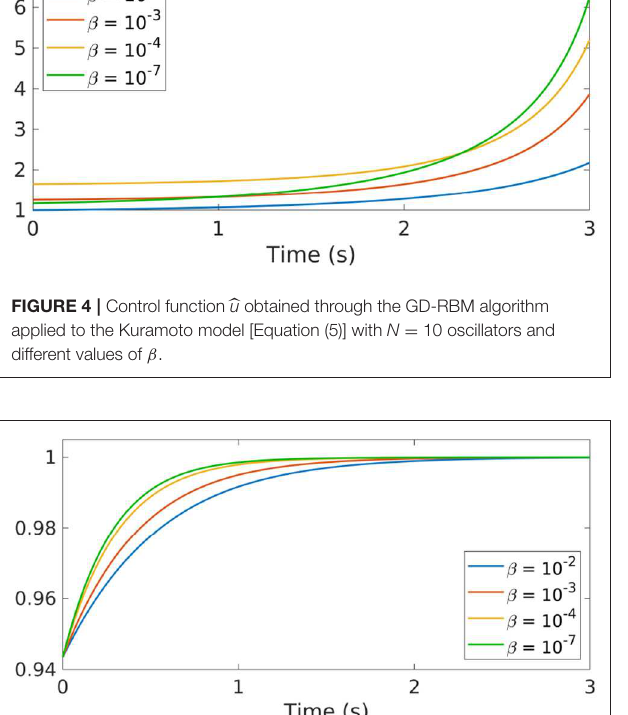
FIGURE 5 | Behavior of the synchronization function r ( t ) corresponding to the controlled dynamics [Equation (5)] for different values of the parameter β